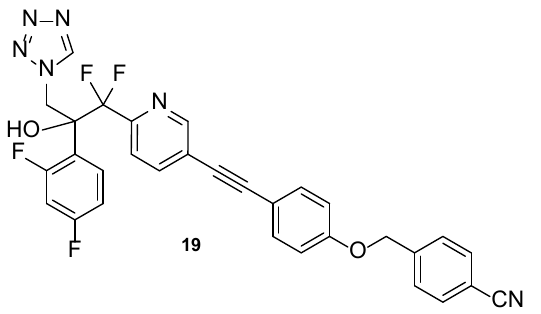
Figure 15. Chemical structure of VT-1598 ( 19 ), a next-generation tetrazole hybrid [62]. Table 6. Clinical trials for VT-1161 ( 17 ) and VT-1598 ( 19 ) (summarized).